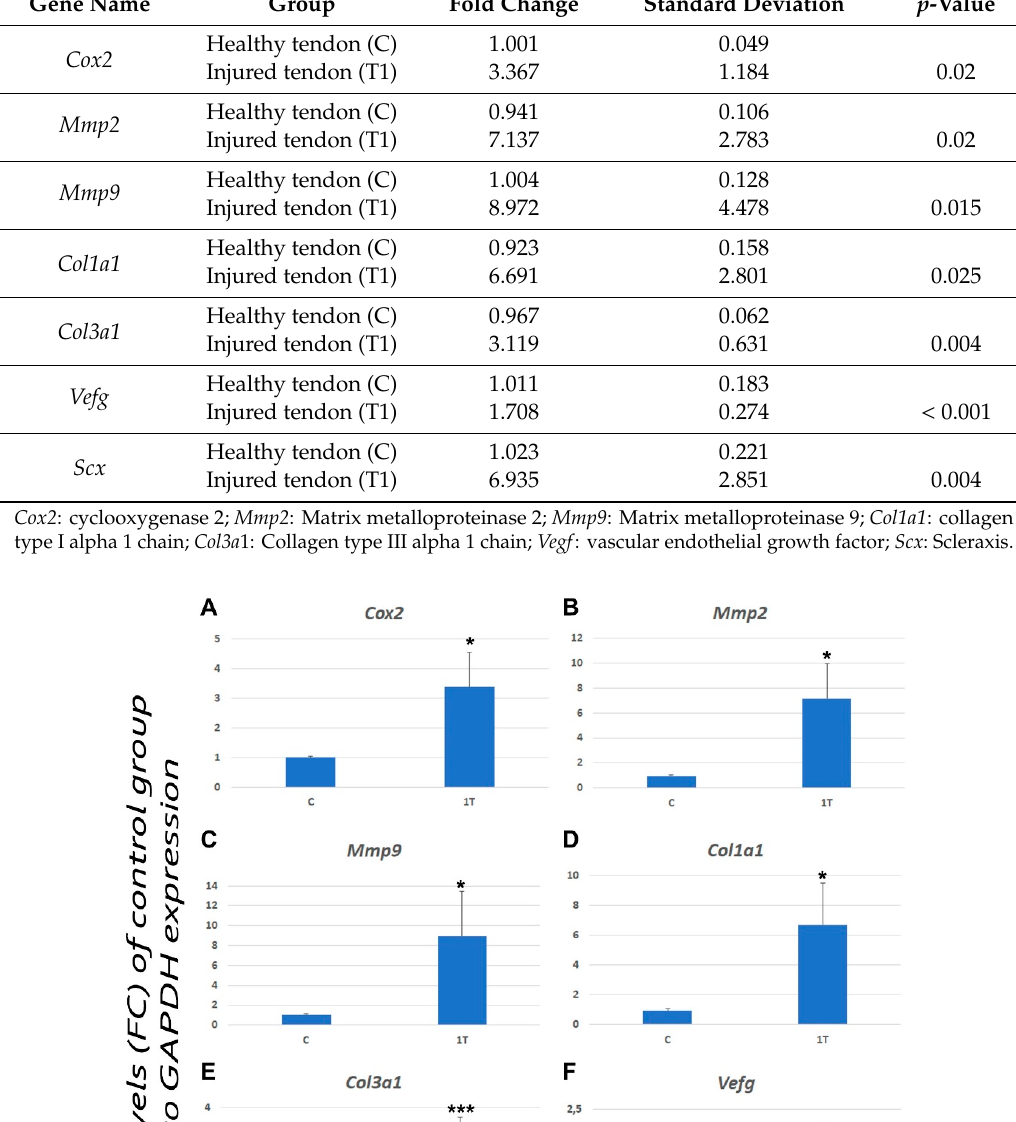
Table 3. Gene Expression Levels in healthy (C) and experimentally injured (T1) Achilles Tendons of Rats (sacrificed at 7 days after the injection).